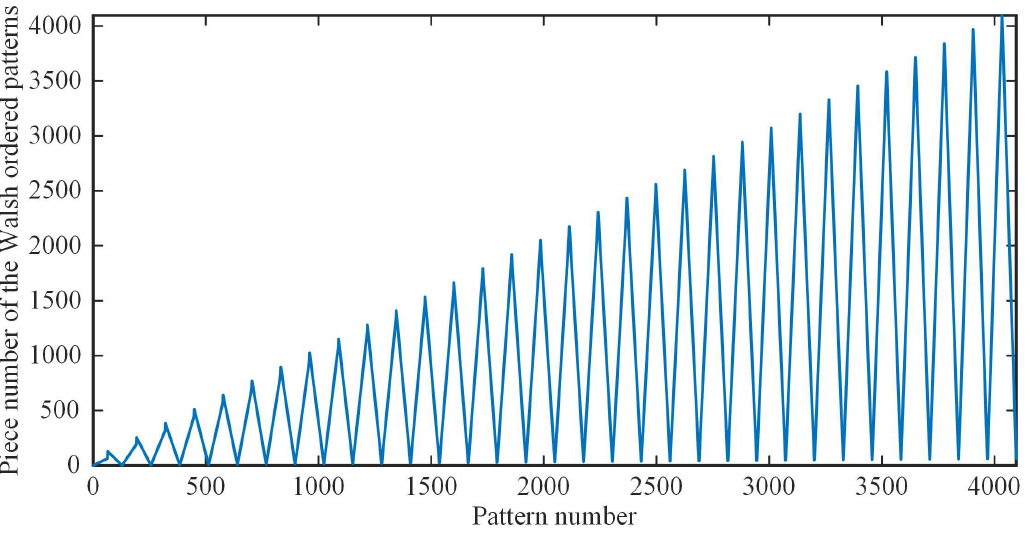
Figure 4. The piece number of the sequency-ordered patterns as a function of the pattern